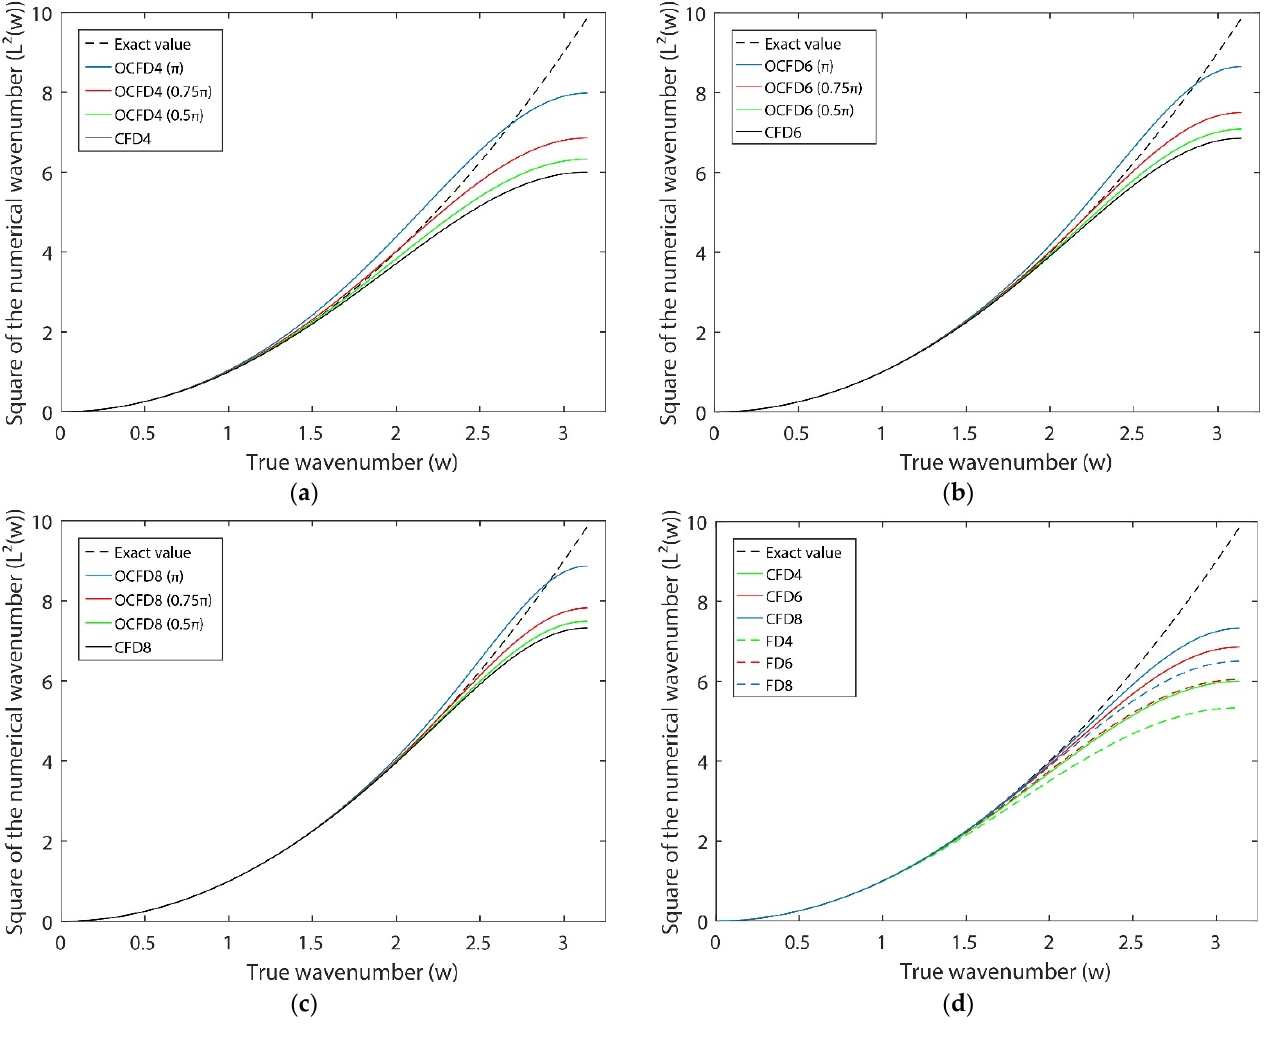
Figure 1. Accuracy curves: ( a ) comparison of the CFD4 and OCFD4 schemes, ( b ) comparison of the CFD6 and OCFD6 schemes, ( c ) comparison of the CFD8 and OCFD8 schemes, ( d ) comparison of the central FD and CFD schemes.